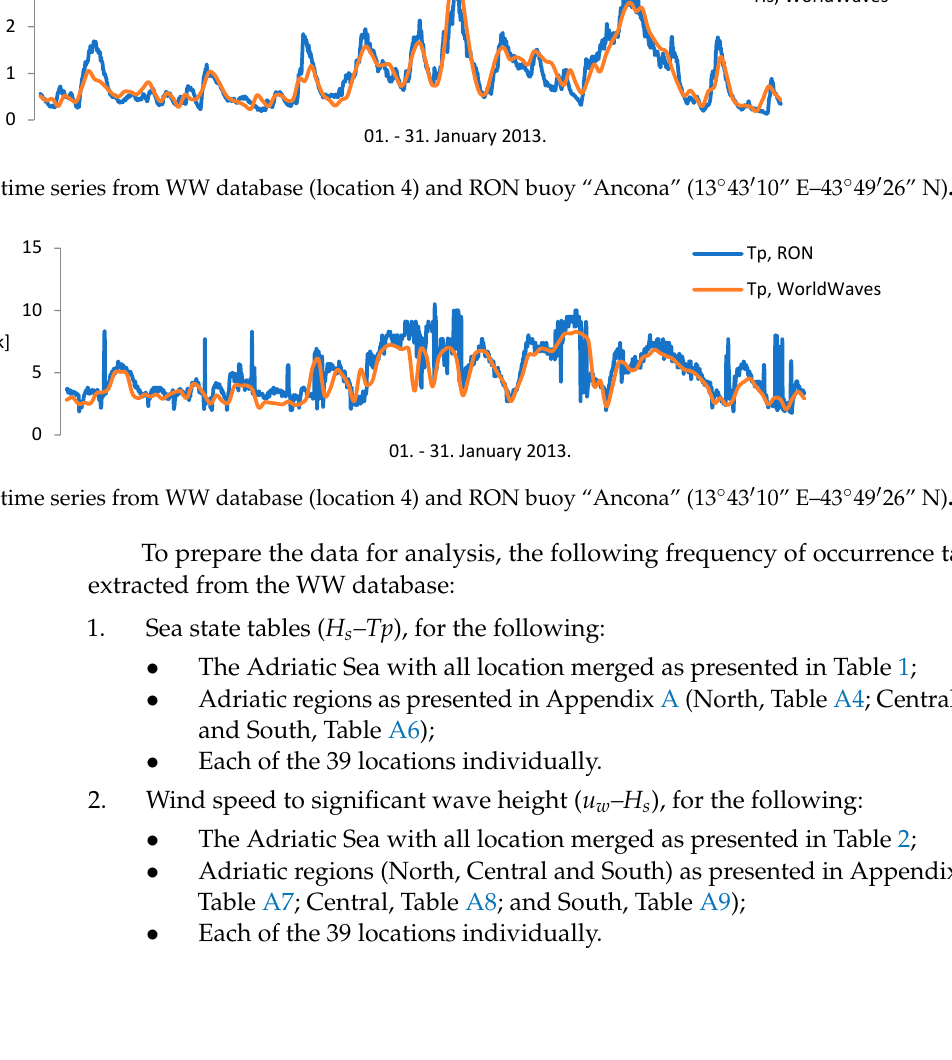
Figure 3. H s time series from WW database (location 4) and RON buoy “Ancona” (13°43 ′ 10 ″ E–43°49 ′ 26 ″ N) .